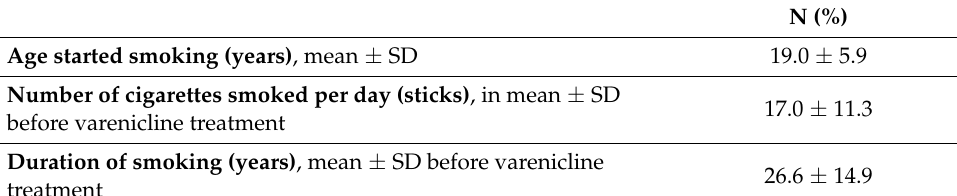
Table 2. Smokers’ characteristics, smoking history and behavior before varenicline treatment (N =